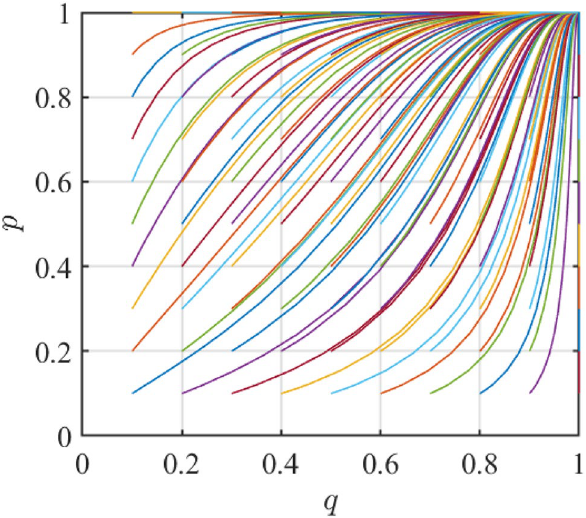
Figure 3. Evolutionary results of 81 times satisfying the E 4 condition.